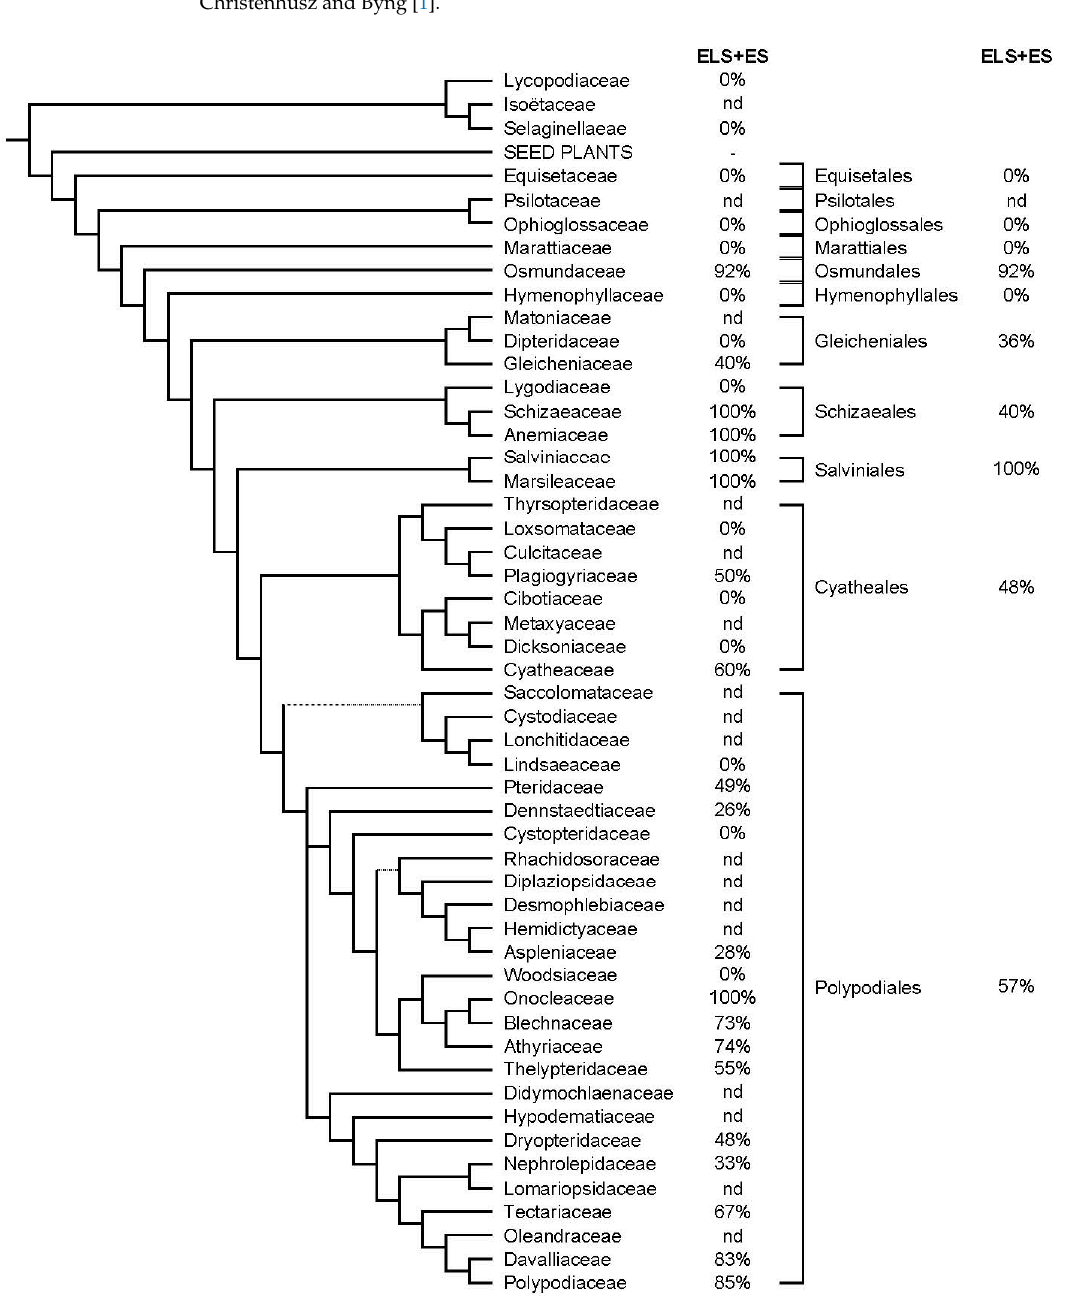
Figure 1. Lycophytes and pteridophytes: Indication of the frequency of ecdysteroid-containing species within the orders of lycophytes and pteridophytes. The classification is according to PPG1 (Ref. [26])